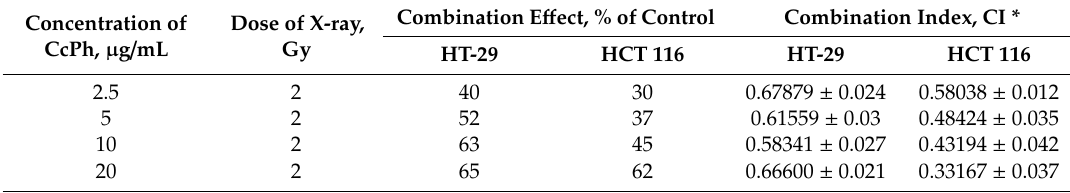
Table 1. Combination index (CI) for phlorethols—X-ray irradiation interactions. Combination E ff ect, % of Control Combination Index, CI * Concentration of Dose of X-ray, CcPh, µ g / mL Gy HT-29 HCT 116